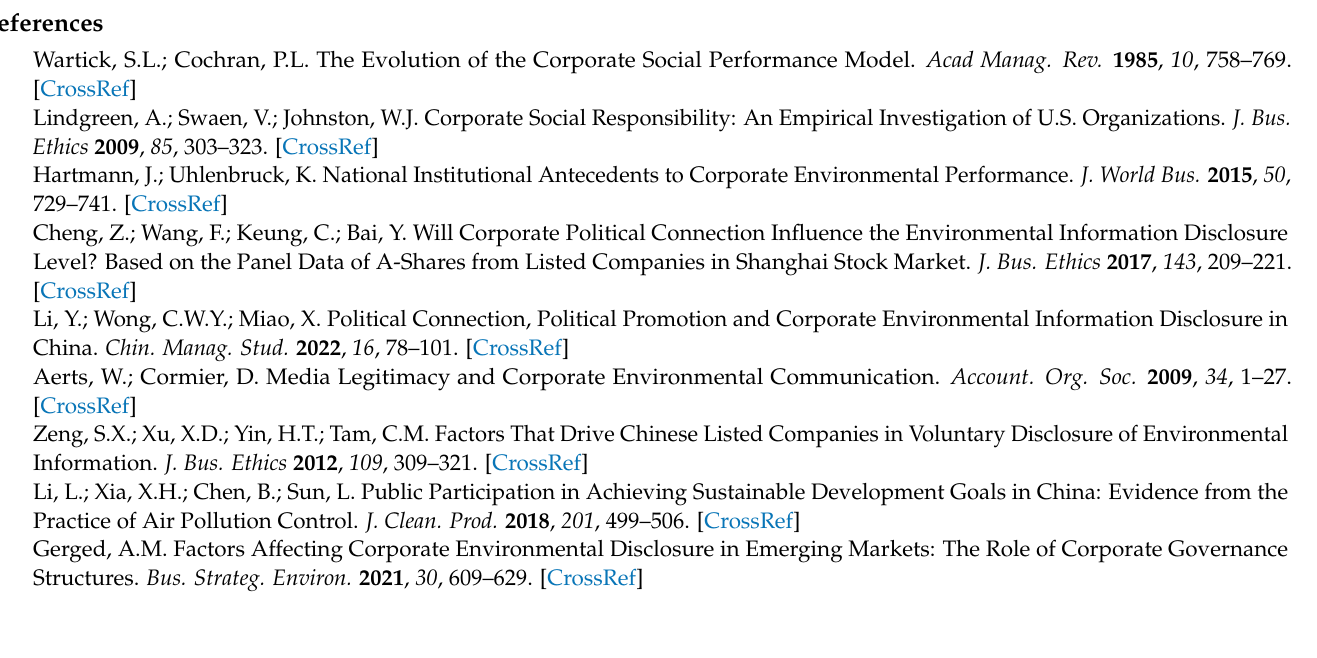
Figure A1. Enterprise digital transformation word frequency diagram.